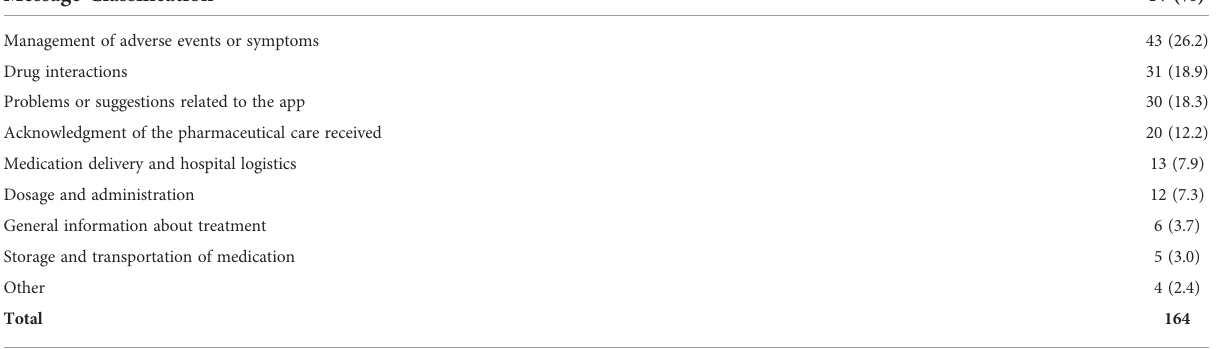
TABLE 3 Type of message sent by patients through eMidCare ® . Message Classi fi